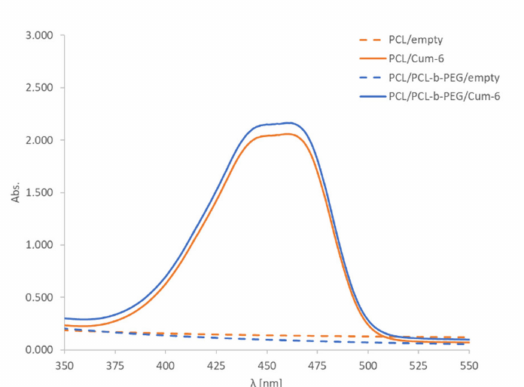
Figure 2. The UV-Vis spectra of PCL and PCL/PCL-b-PEG nanoparticle (~2 × 10 11 nanoparticles/mL) water suspensions containing coumarin-6 (Cum-6). Water was the solvent used for UV-vis spectra.